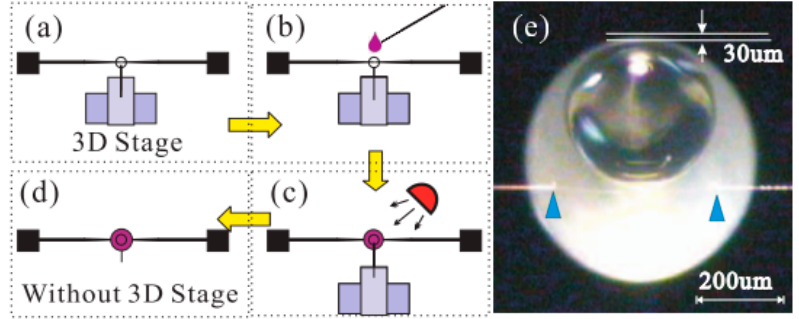
Figure 4. ( a – d ) Schematic diagram of the packaging process of the silica microsphere; ( e ) Microscope picture of the packaged microsphere aligned to the taper. [Reprinted/Adapted] with permission from ref [30], [OSA].